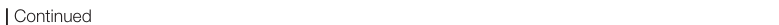
FIGURE 1 | Continued systems are labeled. (C) Location map of survey area off San Onofre and coastal communities of Dana Point and San Clemente. Location of Las Pulgas Road within Marine Corps Base Camp Pendleton is also shown. Survey area bounds on continental shelf are outlined with a black rectangle. Shown here in white are segments of the Newport-Inglewood Rose Canyon (NIRC) fault system from Sahakian et al. (2017). Solid and dashed red fault segments from USGS Fault and Fold database (U.S. Geological Survey [USGS] and California Geological Survey [CGS], 2006). Yellow solid lines within the survey box denote locations of crosslines and arbitrary line shown in the figures. Yellow dashed line represents path of SIO CHIRP line displayed in Figure 10 . Also shown are sampled core locations from TN336 cruise.